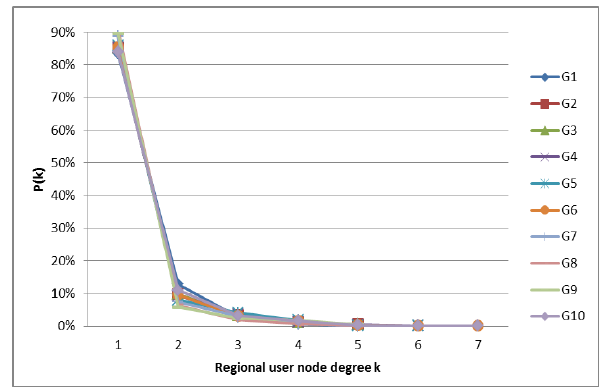
Figure 3. Regional user node degree distribution of the ten weighted bipartite networks